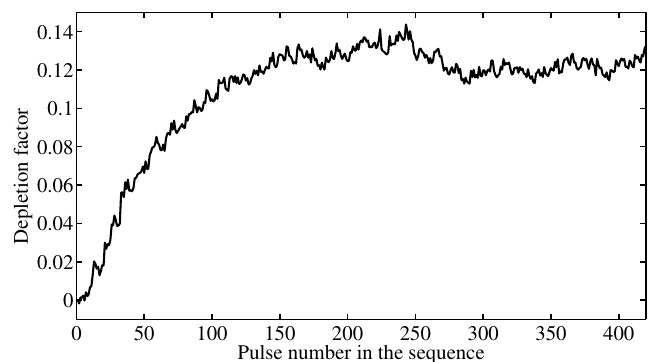
Figure 8. Depletion factor of the pulses of a long code length